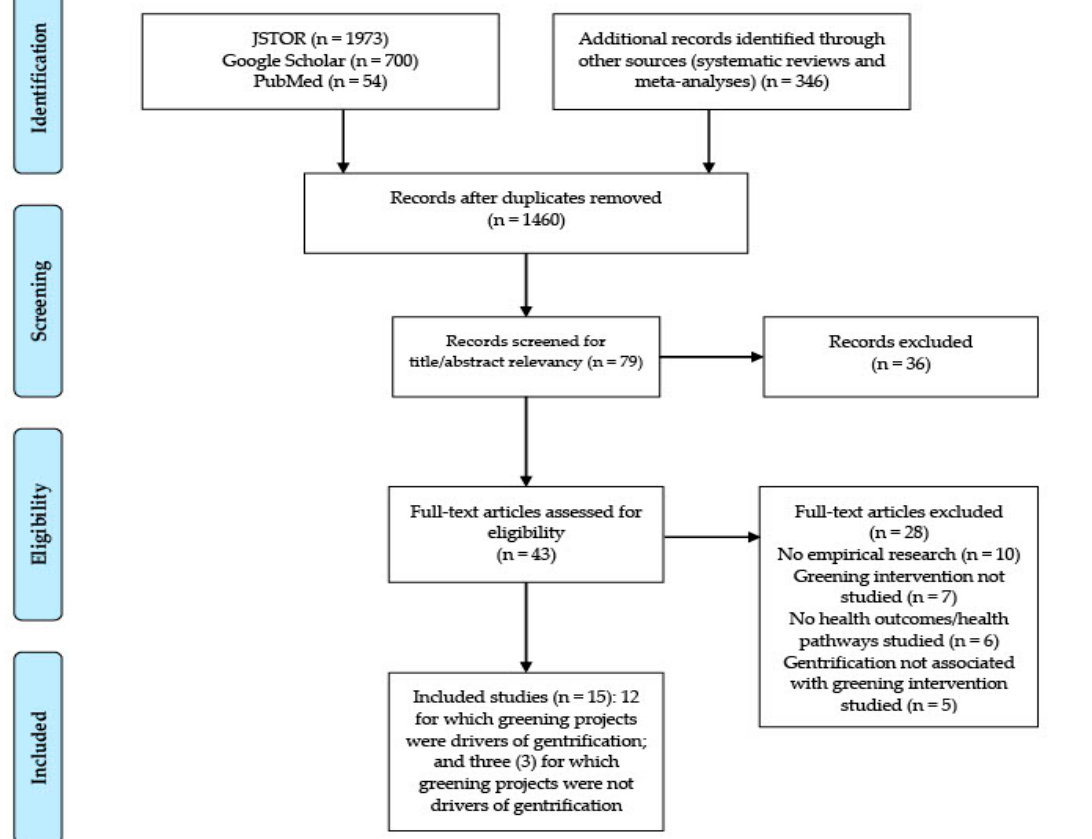
Figure 1. PRISMA (Preferred Reporting Items for Systematic Reviews and Meta-Analyses) Flow Diagram.